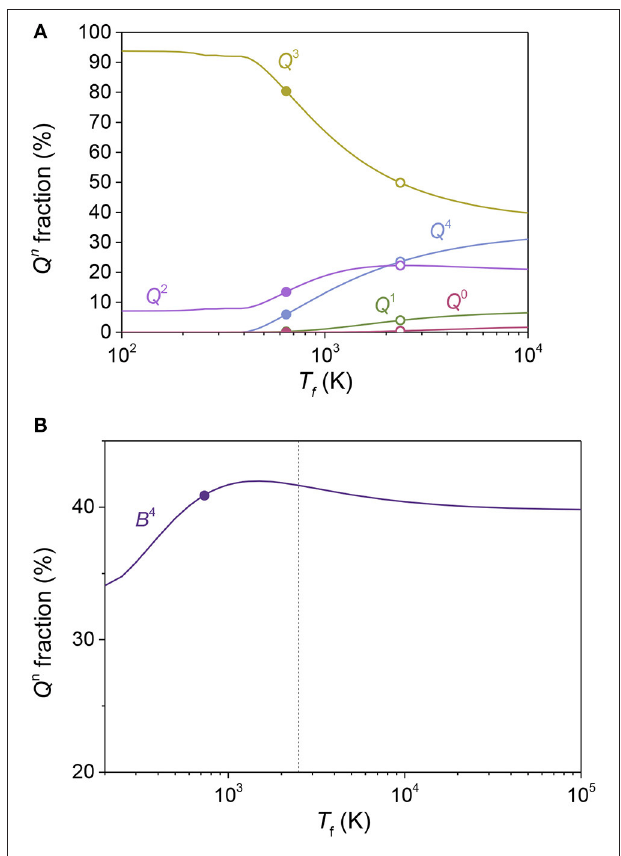
FIGURE 2 | The fraction of structural units in (A) 35Na 2 O-65SiO 2 and (B) 40Li 2 O-60B 2 O 3 glasses as a function of fictive temperature ( T f ). (A) The closed symbols represent 29 Si MAS-NMR experimental data (Maekawa et al., 1991 ), the open symbols represent MD simulated data (Adkins and Cormack, 2011), and the solid lines represent the model predictions. (B) The closed symbol represent 10 B NMR experimental data (Feller et al., 1982) and the dashed line is an estimate of T f of the MD simulated glass. The solid line represents the model